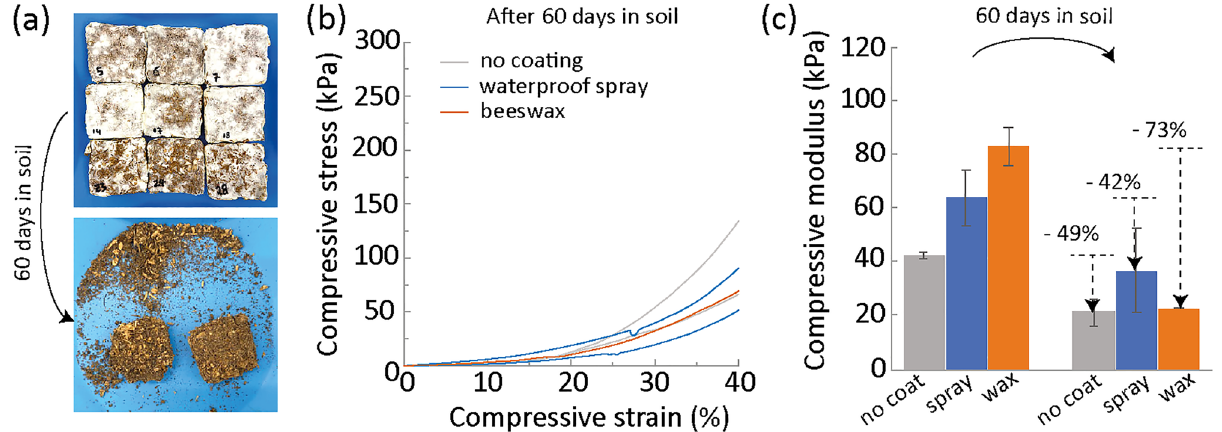
Figure 5. Composting of MBCs with no coating (grey), waterproof spray coating (blue) and beeswax coating (orange). ( a ) Pictures of the MBCs before and after 2 months in soil. Width of the samples is 3 cm for all. All samples looked identical irrespective of their coating. ( b ) Stress–strain curves obtained under compression for the mycelium-bound composites after 2 months in soil. ( c ) Elastic modulus of the samples before and after 2 months in